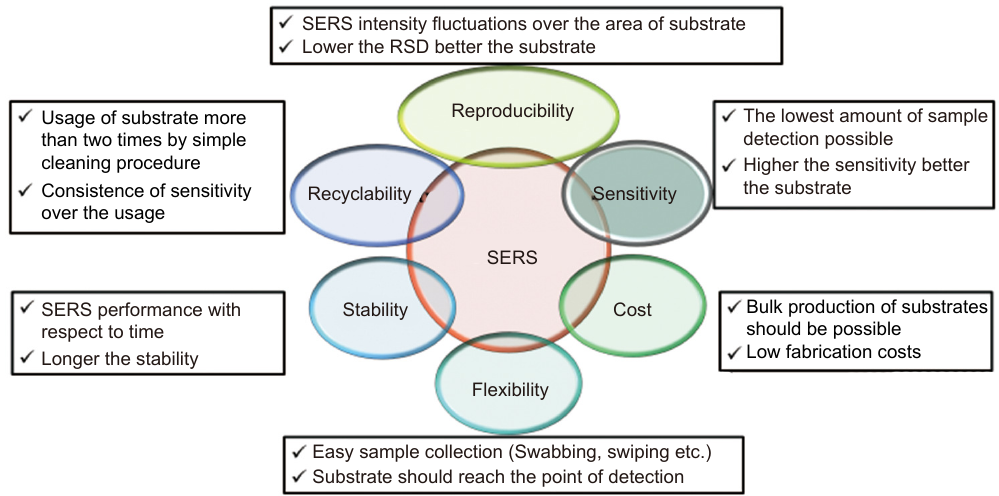
Fig. 2 | The ideal requirements of SERS substrates are summarized in this